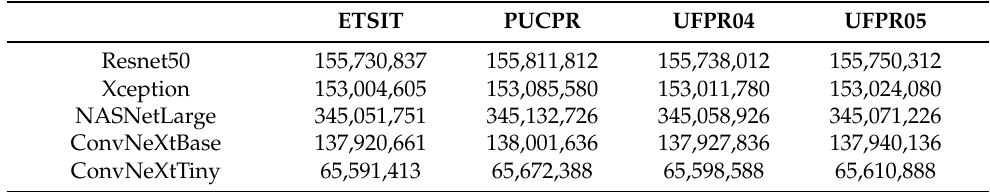
Table 5. Number of parameters of the complete model for each backbone and each dataset.